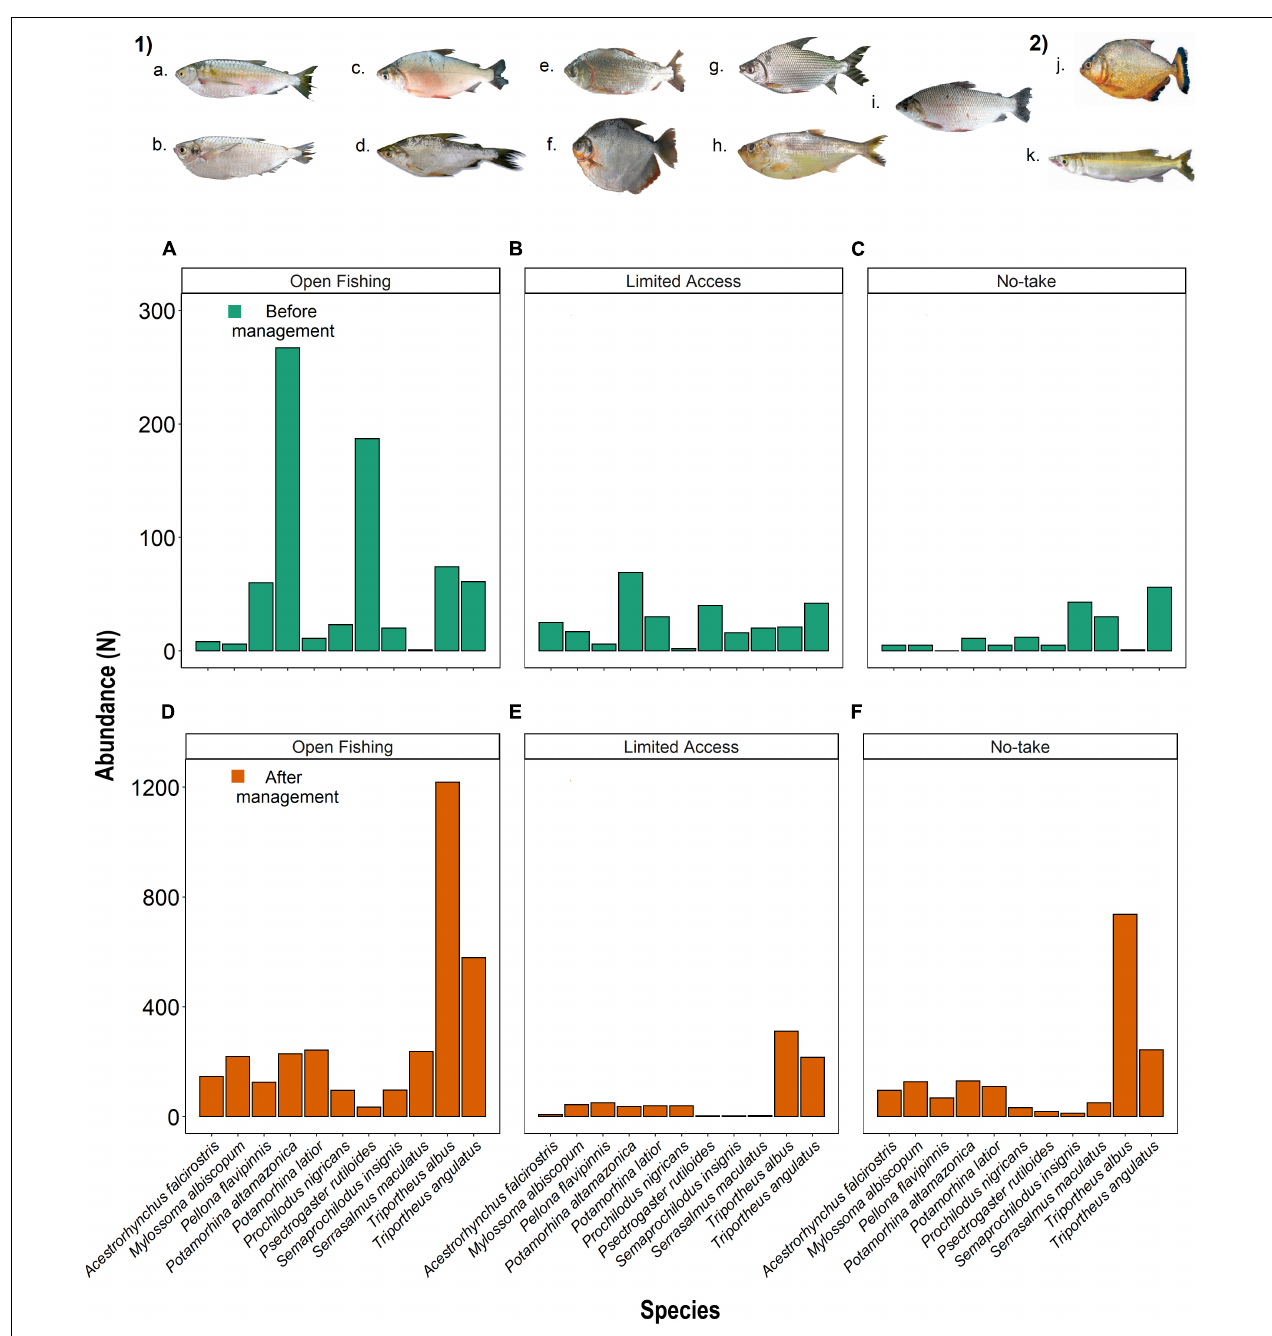
FIGURE 5 | Numerical abundance of fish species that contributed most to the observed similarities, according to SIMPER analysis among lakes of distinct categories of management: Before co-management (A) Open fishing, (B) Limited access, (C) No-take and after co-management (D) Open fishing, (E) Limited access, (F) No-take. (1) Short and medium distances migrants: (a) Triportheus albus, (b) Triportheus angulatus, (c) Potamorhina altamazonica , (d) Potamorhina latior , (e) Psectogaster rutiloides , (f) Mylossoma albiscopum , (g) Semaprochilodus insignis , (h) Pellona flavipinis , (i) Prochilodus nigricans ; (2) Sedentary species: (j) Acestrorhynchus falcirostris , (k) Serrasalmus maculatus . Photos: Soares et al. (2007).